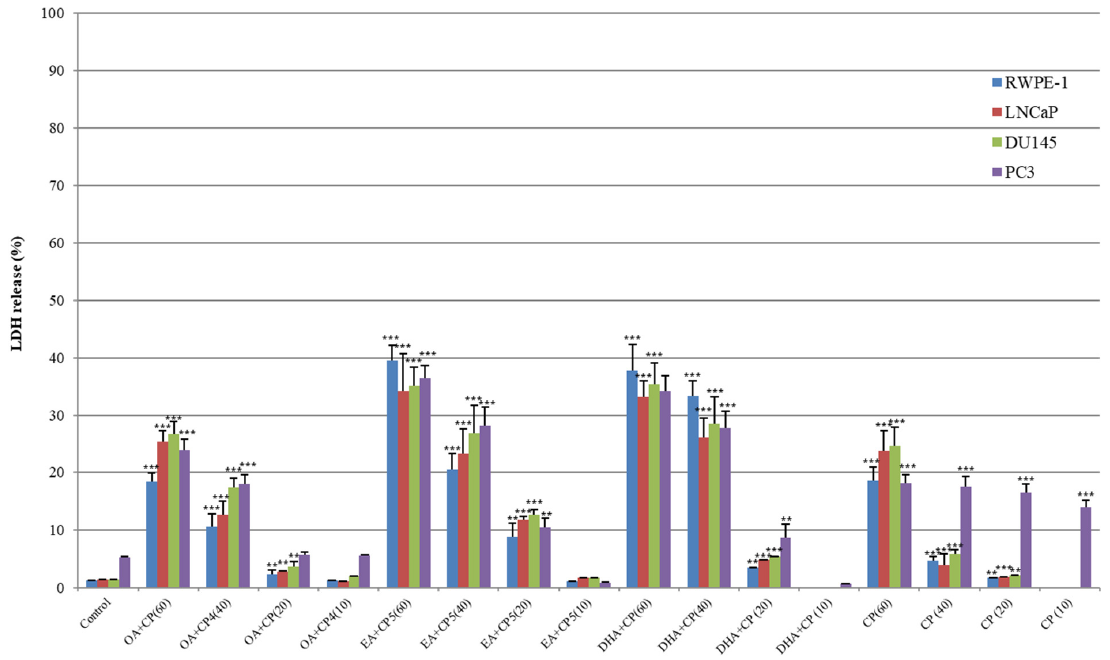
Figure 3. The amount of released lactate dehydrogenase (%) depending on the concentration of a mixture of ciprofloxacin (CP) and individual fatty acid OE—oleic acid; EA—elaidic acid and DHA -docosahexaenoic acid in cancerous LNCaP, DU145 PC3 and normal RWPE-1 cell lines. Tested compounds were tested at concentrations of 60 µM, 40 µM, 20 µM and 10 µM. Significance levels explanation *** p < 0.001; ** p < 0.01.